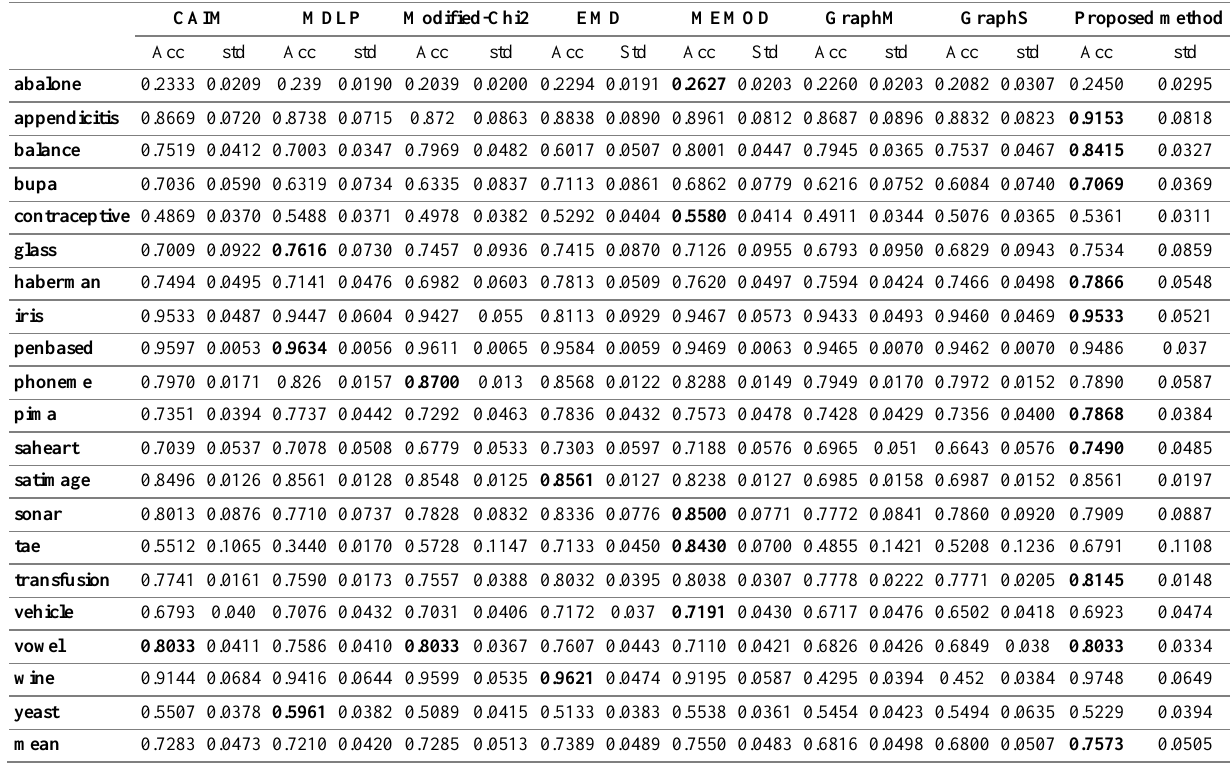
Table 6. The classification accuracy obtained by C4.5.